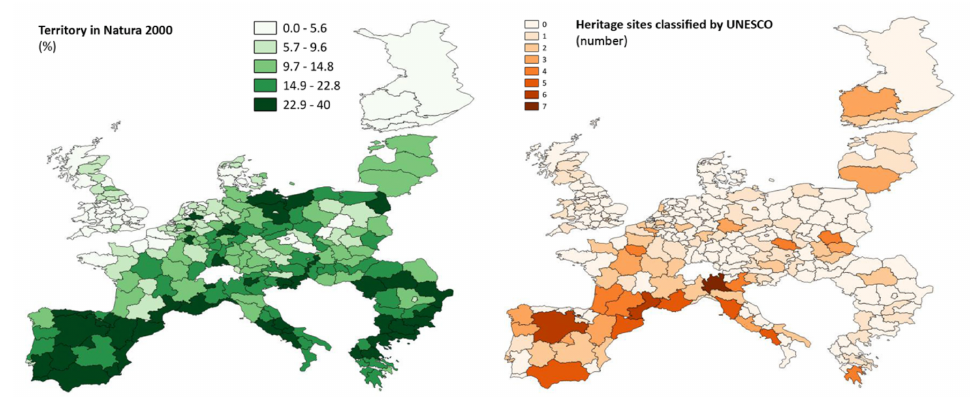
Figure 2: Natural and cultural